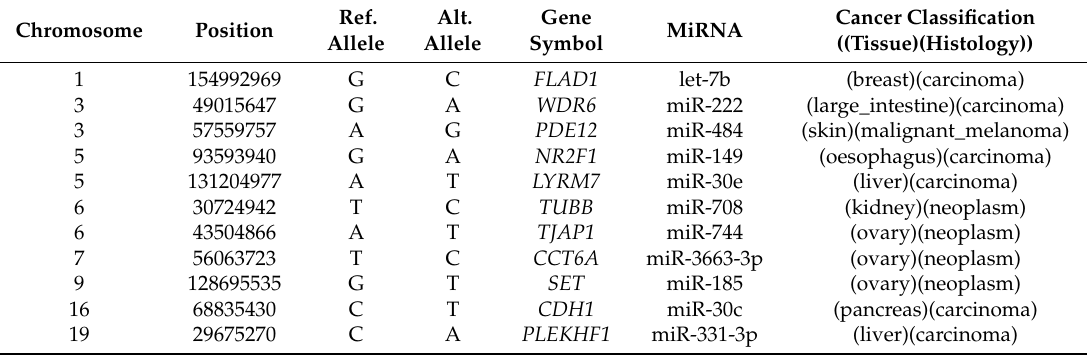
Table 2. Somatic SNVs located in miRNA target sites (MTS) identified by CLASH (cross-linking, ligation, and sequencing of hybrids)